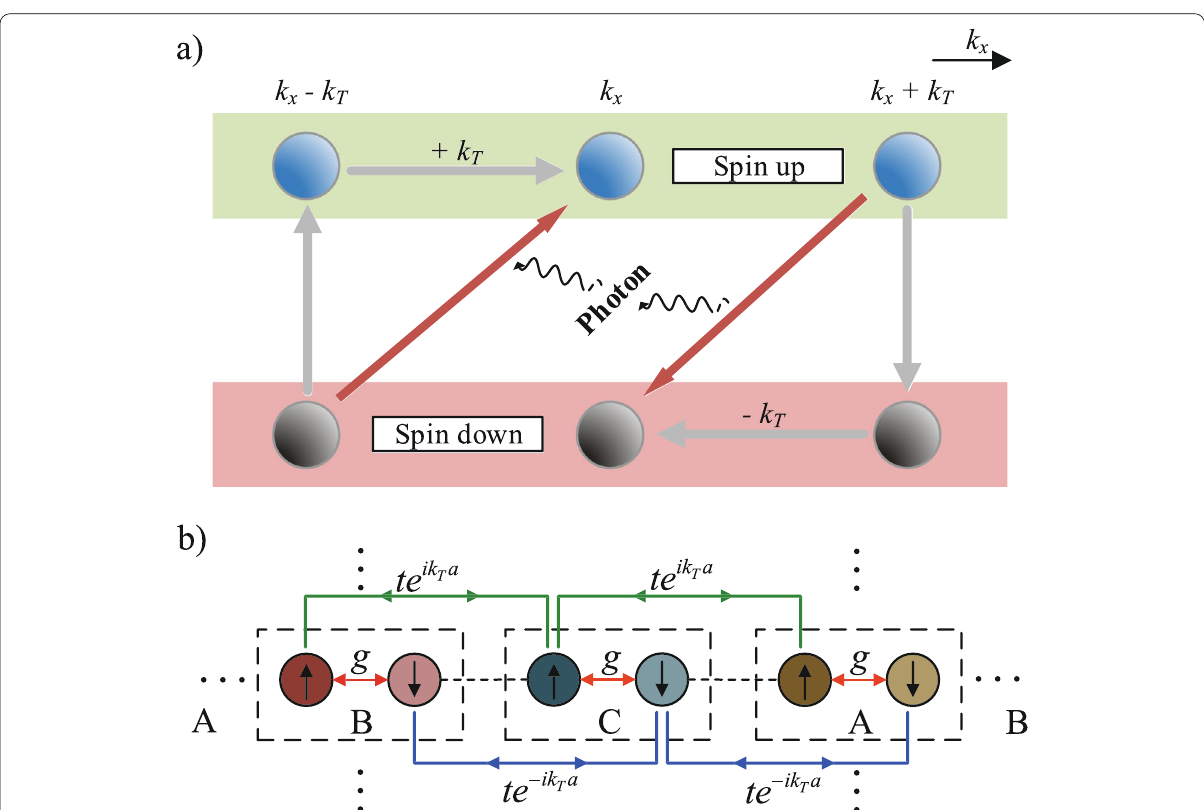
Fig. 2 a Schematic diagram of the coupling between the field (photon) and the system(atoms in the lattice). The blue and gray spheres represent atoms of spin up and spin down, respectively. b Schematic diagram of the coupling of pseudospins defined by ˆ H total at α = 1 / 3 . The dashed rectangular box represents the coupling(red lines) between the pseudospins inside the lattice. The solid green and blue lines indicate the couplings of spin up and down between different lattices,